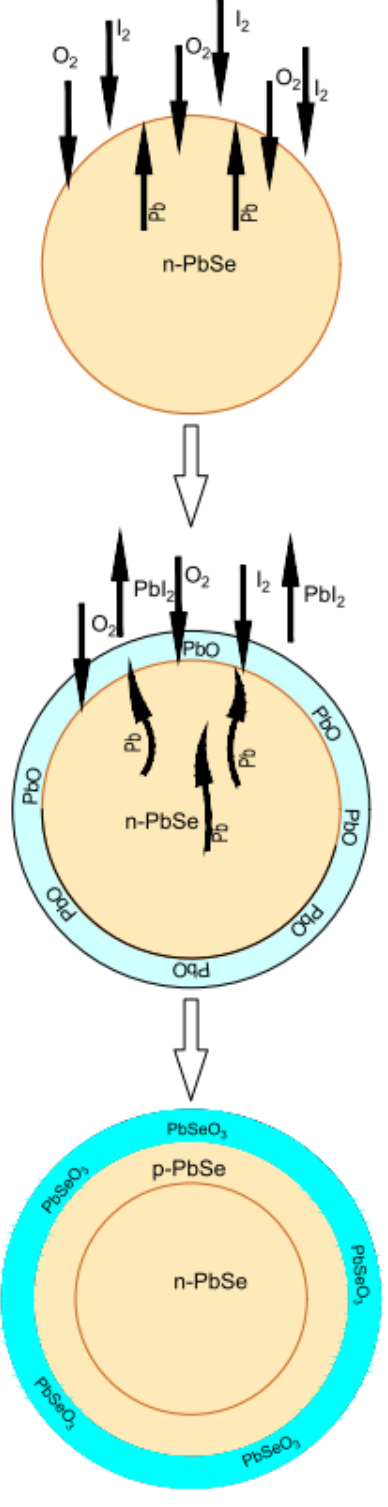
Figure 5. The oxidation process of the n-PbSe grain in the presence of I 2 vapor (schematically). In the presence of iodine vapor, the growth of the oxide layer slows down, because a metal atom coming out to the surface will react more efficiently with iodine than with oxygen, forming volatile lead and cadmium iodides.